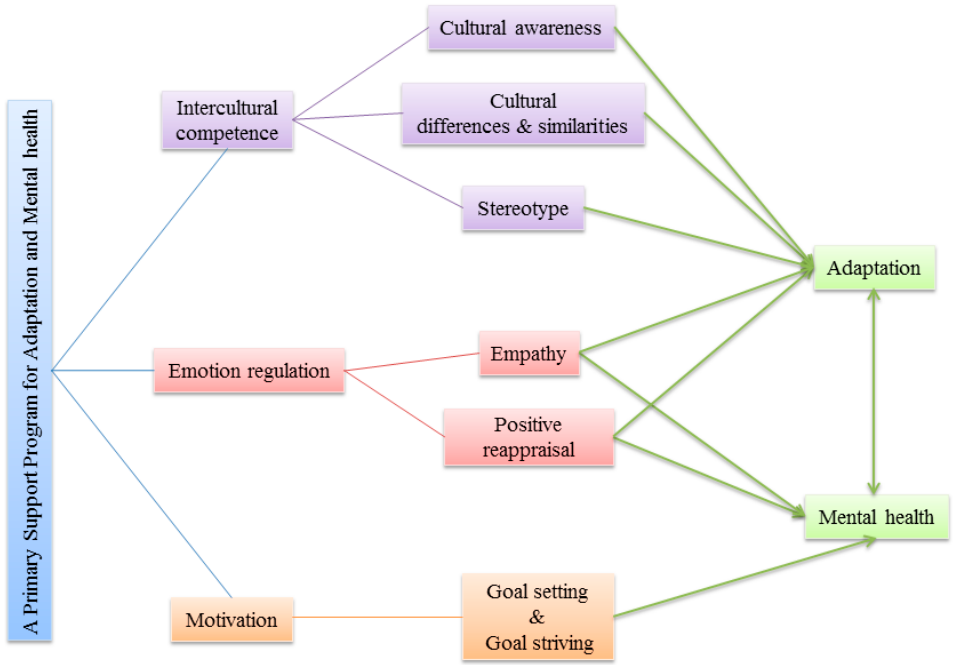
Figure 1. A working model for a primary support program for adaptation and mental health.